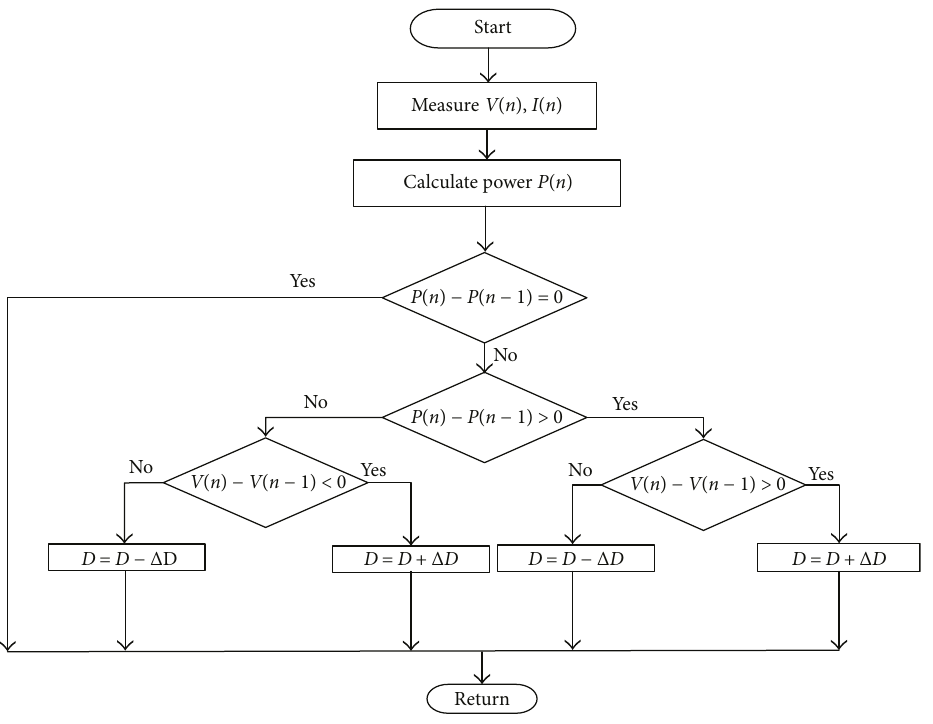
Figure 1: The fl owchart of the P&O